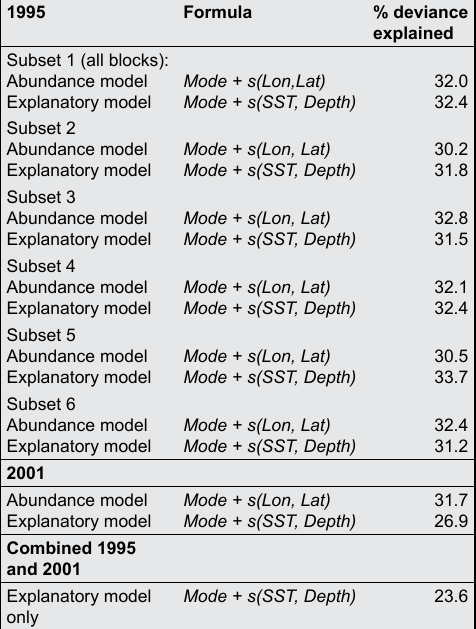
Table 2. Selected terms in the GAMs. s (.) denotes inclu- sion of the covariate as a smooth function in the model. Initially, smooth functions were allowed 7 knots for 1D smooths and 14 knots for 2D smooths. ‘Abundance model’ refers to the model used to estimate abundance whereas ‘explanatory model’ refers to the model used to examine the relationship between density and environmental vari-